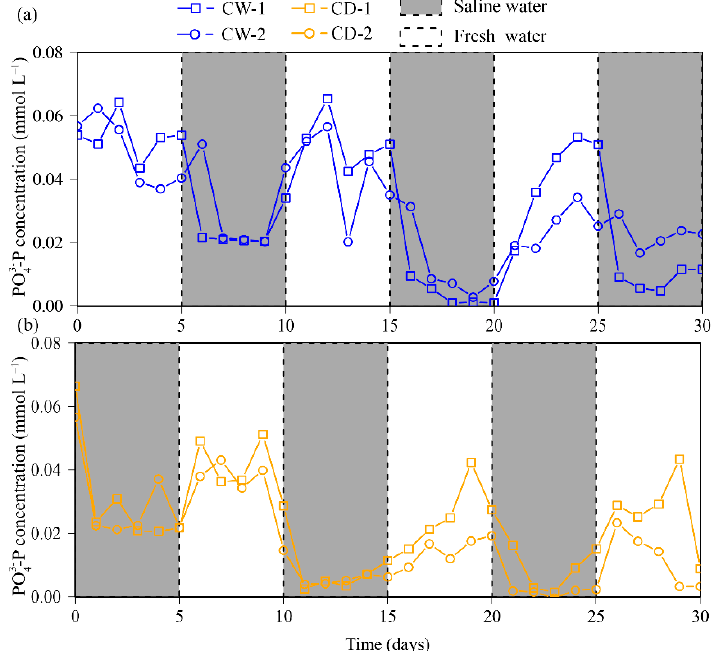
Figure 6. Phosphate (PO 43 − -P) release from peat soils under saline–fresh water cycles: ( a ) coastal rewetted, CW; and ( b ) coastal drained, CD.